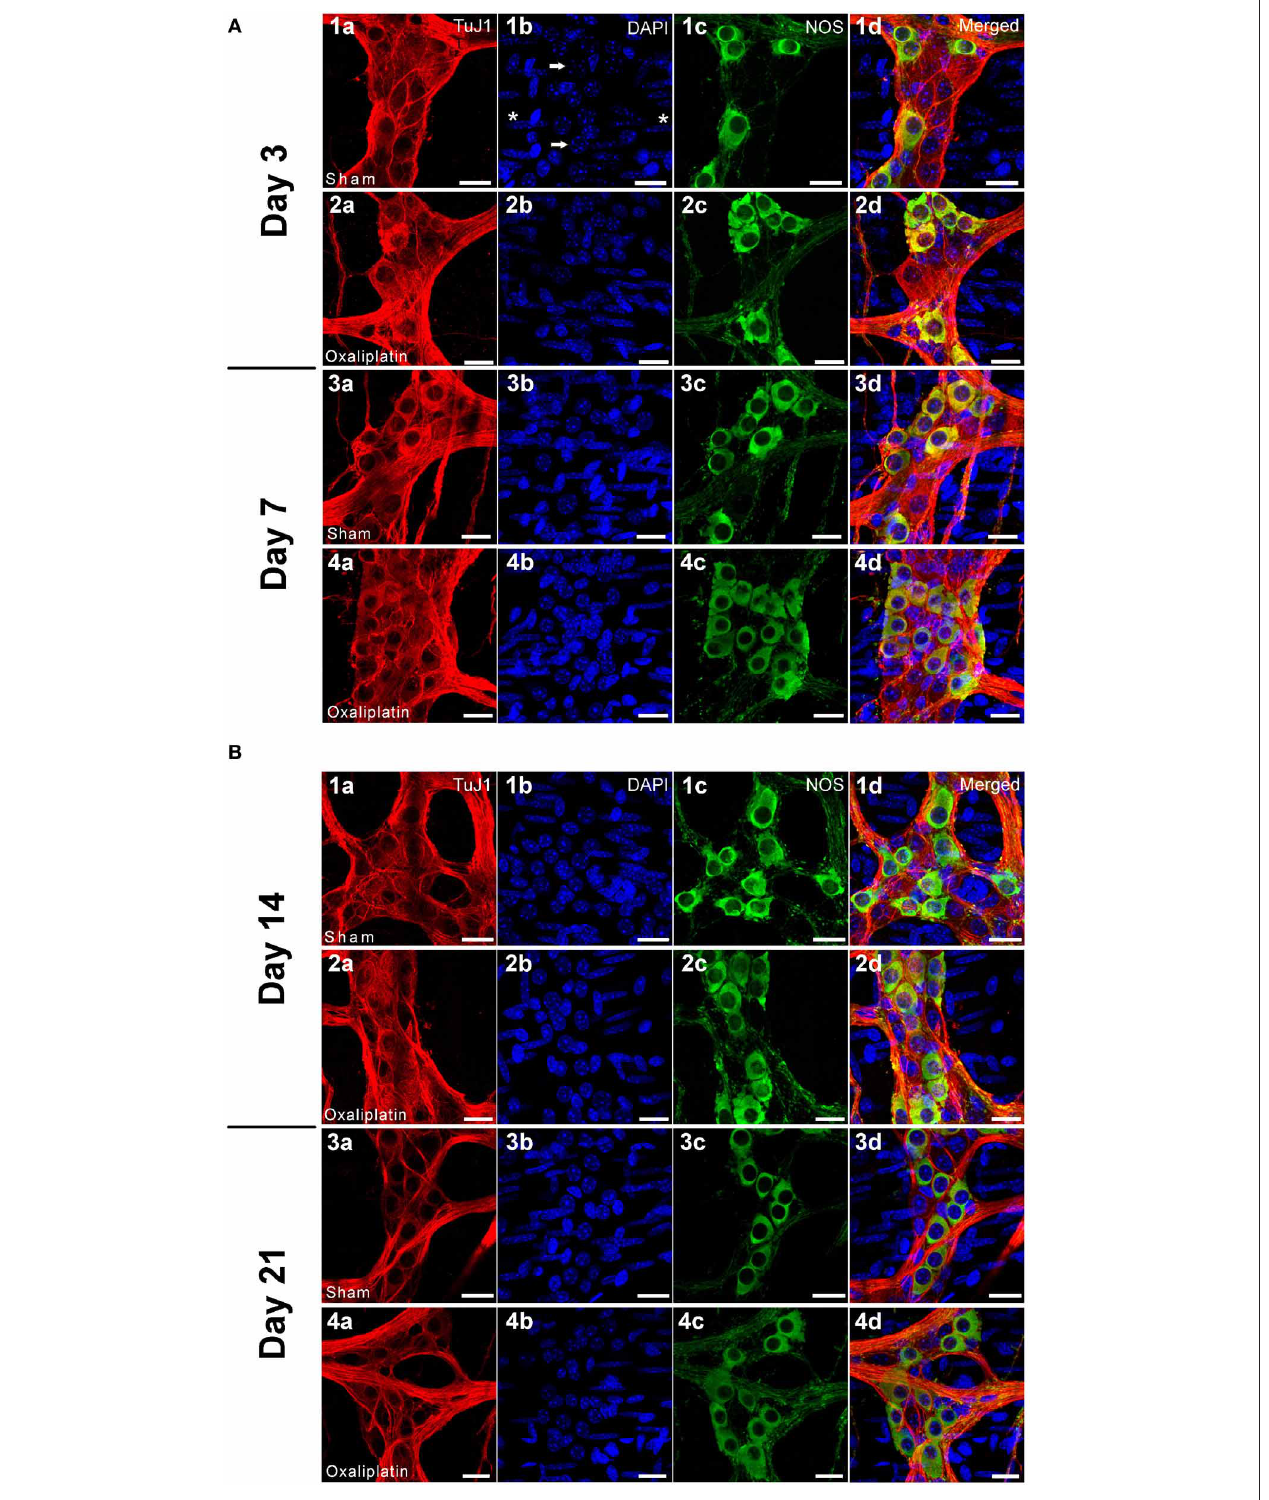
β -Tubulin Tuj1 (red), nuclei labeled with DAPI (blue) (arrows) can be seen within the ganglion (1b). Smooth muscle cells (asterisks) are also labeled with DAPI (1b). Significant increase in the proportion of NOS neurons